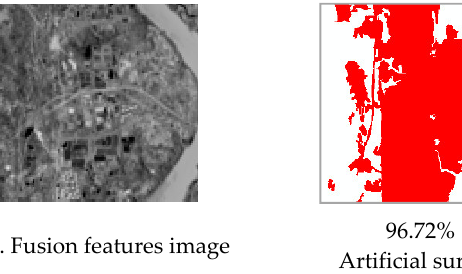
Figure 14. Comparison of classification results. (Remark: the accuracies in subfigures represent the PA of different datasets).